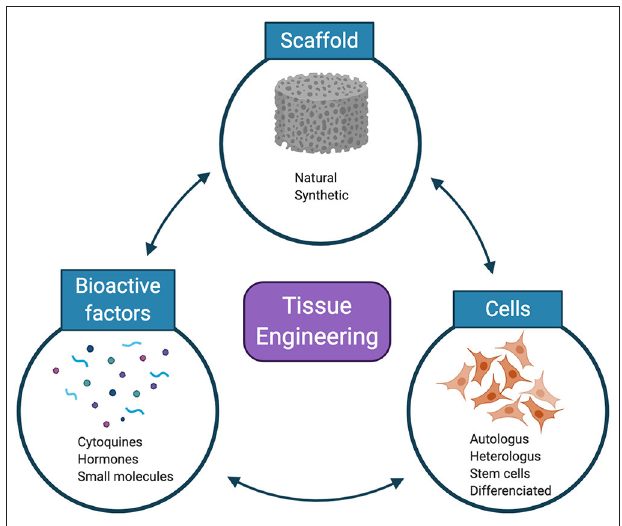
FIGURE 5 | The tissue-engineering triad. Scaffolds, cells, and bioactive factors are used in isolation or in combination to recapitulate the desired tissue.